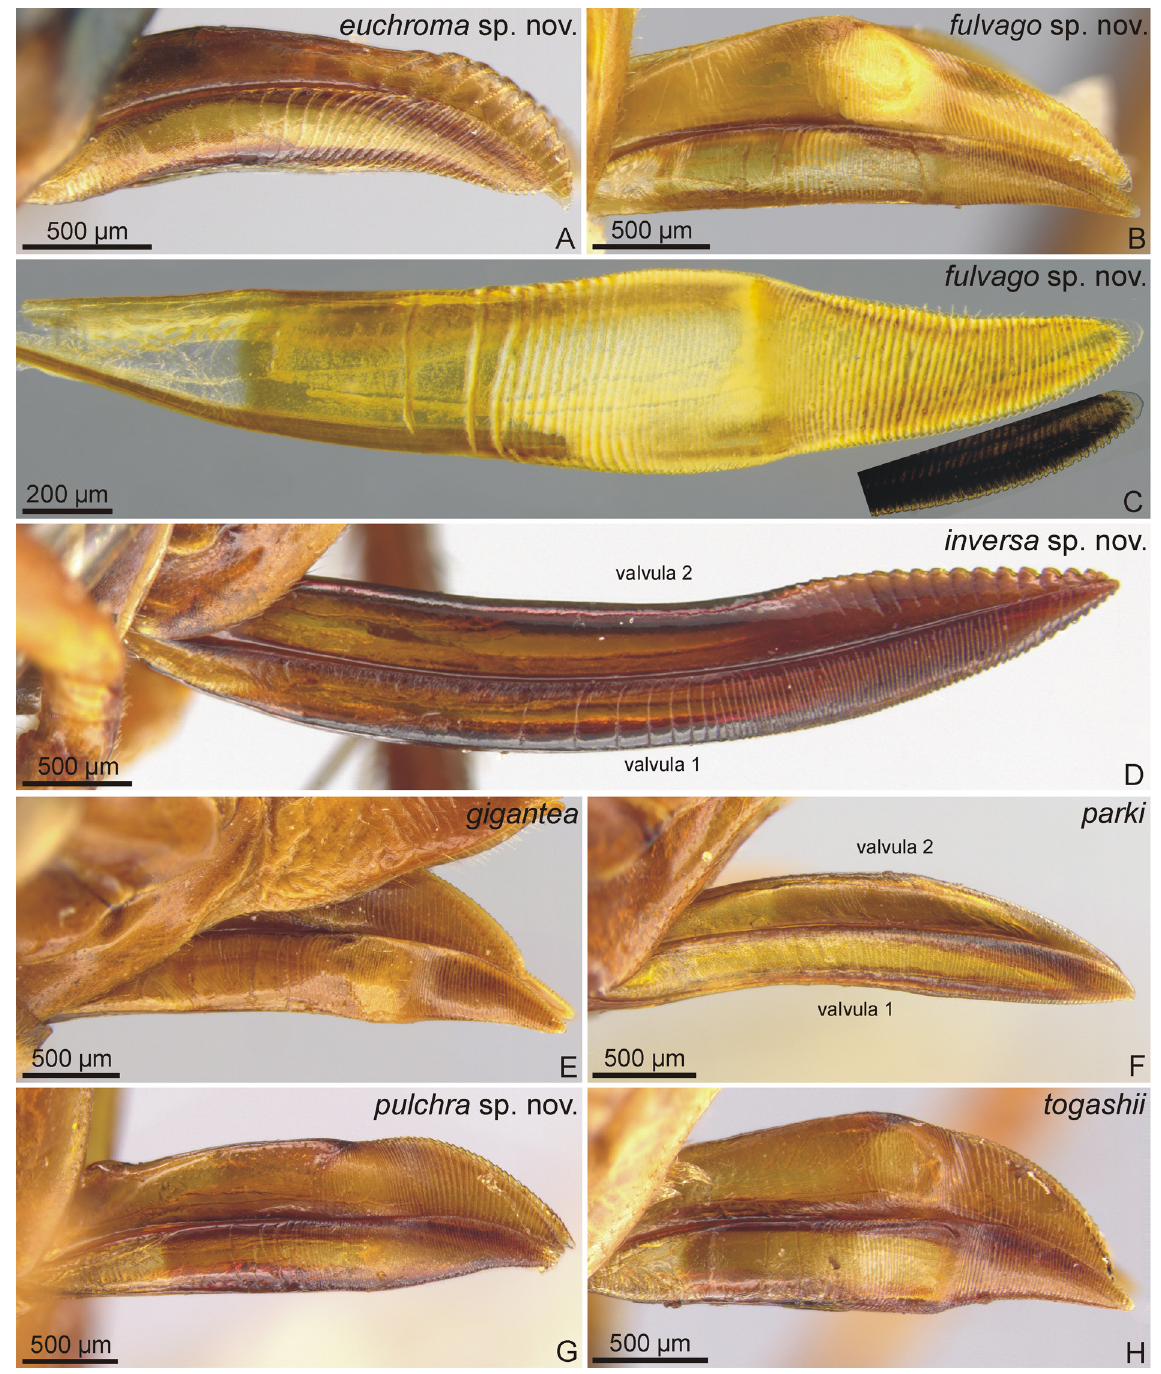
Fig. 12. Species of Megaxyela Ashmead, 1898, ovipositors. A . M. euchroma Blank, Shinohara & Wei sp. nov., paratype, DEI-GISHym 22510 (NSMT). B–C . M. fulvago Blank, Shinohara & Wei sp. nov., paratype (5752, NSMT). C. Complete valvula 2 (incident light) and tip of valvula 2 (insert, transmitted light). D . M. inversa Blank & D.R. Smith sp. nov., paratype (22356, USNM). E . M. gigantea Mocsáry, 1909, holotype of M. mikado Sato, 1930 (22350, NSMT). F . M. parki Shinohara, 1992, paratype (18510, NSMT). G . M. pulchra Blank, Shinohara & Sundukov sp. nov., paratype (22348, NSMT). H . M. togashii Shinohara, 1992 (22353, NSMT). The images in B and H have been flipped